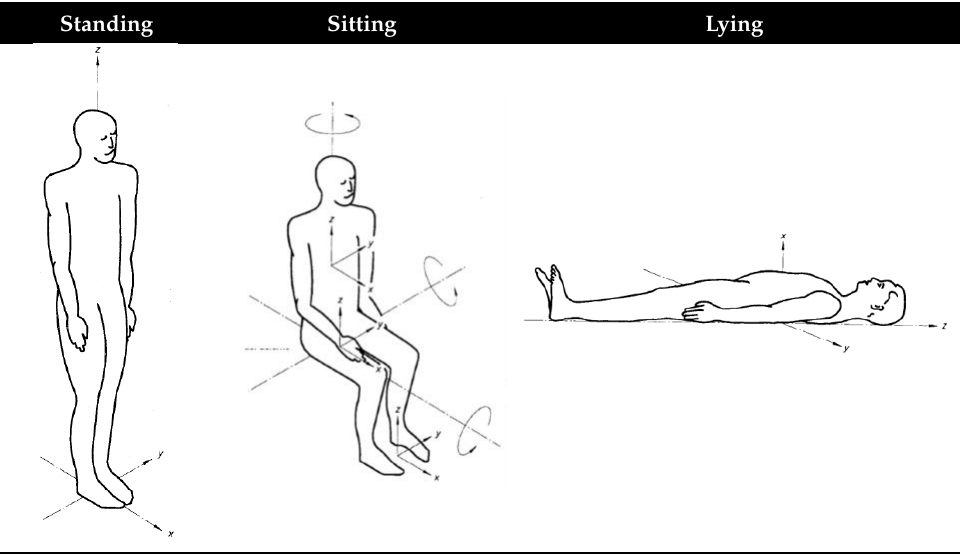
Table 1. UNE-2631 basic centric axes of the human body [13] . Standing Sitting Lying